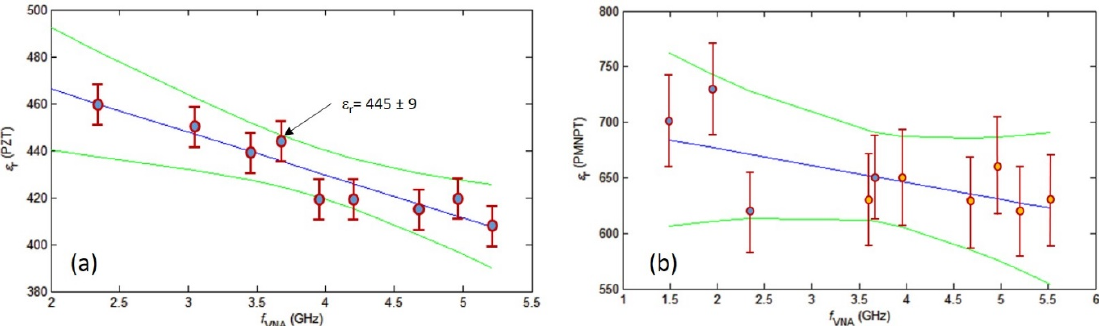
Figure 10. Dielectric constant of PZT ( a ) and PMN-PT ( b ) samples as a function of the VNA frequency. The error bars correspond to the combined uncertainty.